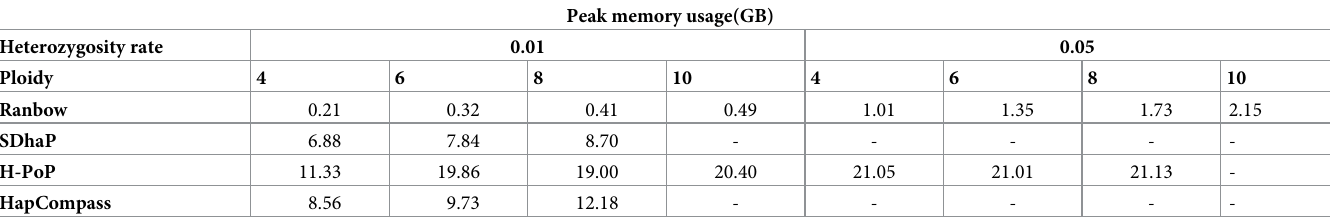
Table 3. Average peak memory usage on All a dataset with 0.01 and 0.05 heterozygosity. “-” represent the methods failed to